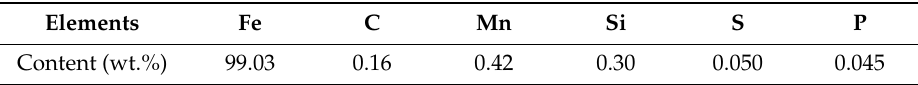
Table 1. The chemical composition of the Q235 steel